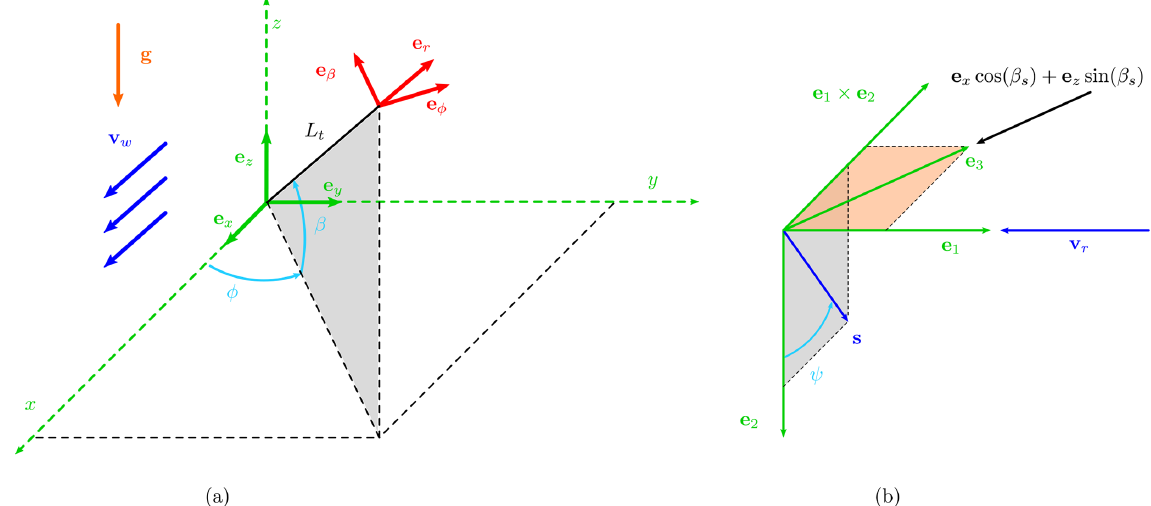
Figure 1. (a) Ground reference frame F G ( e x − e y − e z ) and spherical reference frame F S ( e r − e φ − e β ) and (b) sketch for the spanwise unit vector s